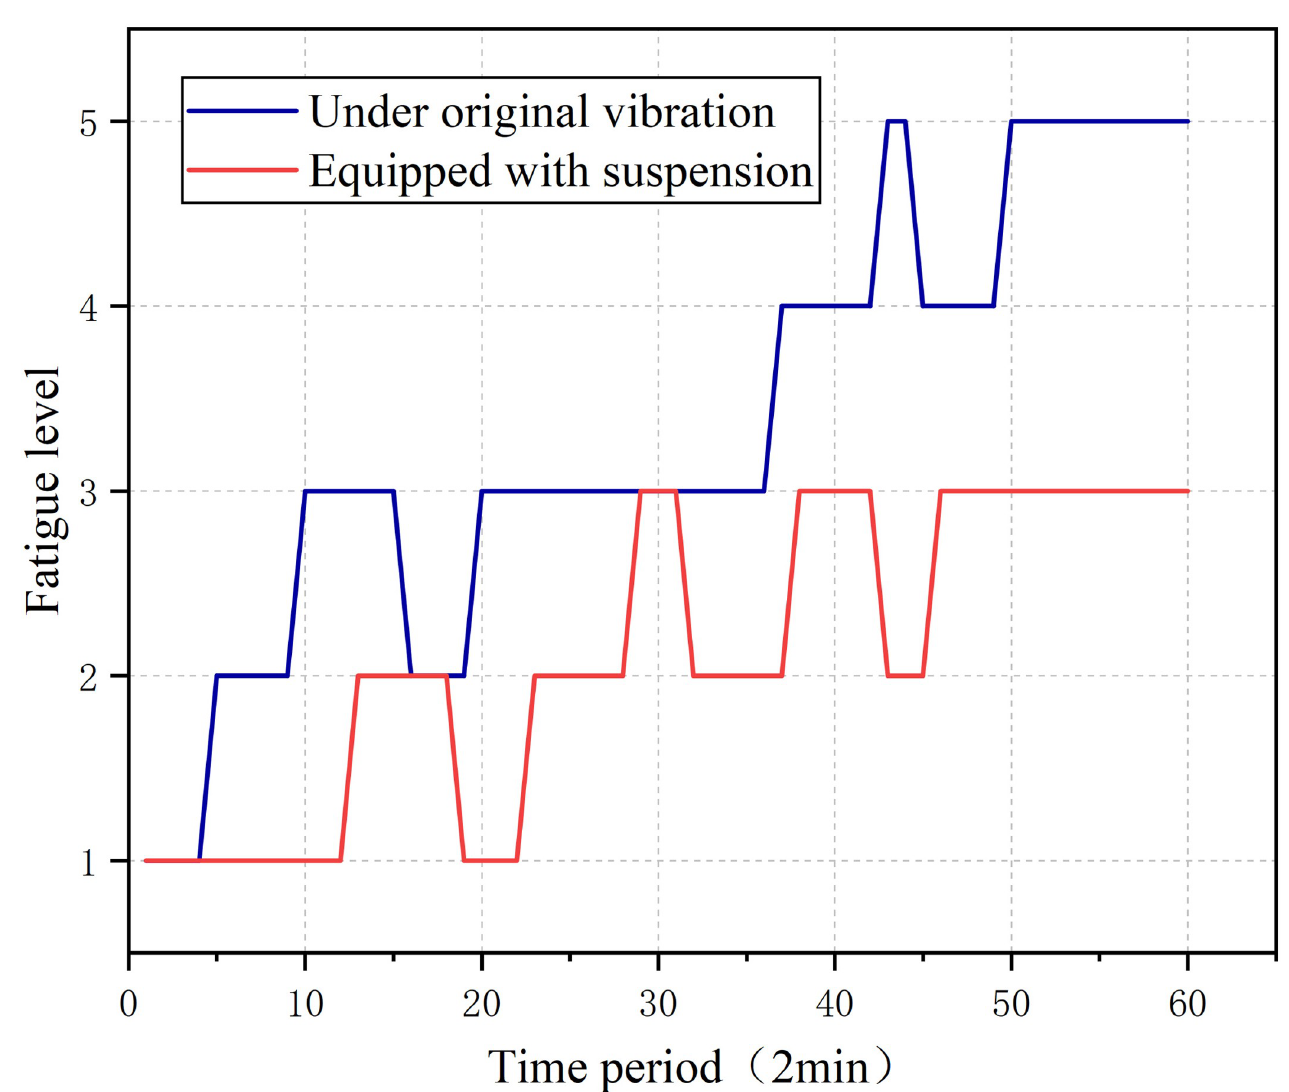
Fig 24. Comparisons and analysis of comfort evaluation between vibration absorbing seat suspension and ordinary seat